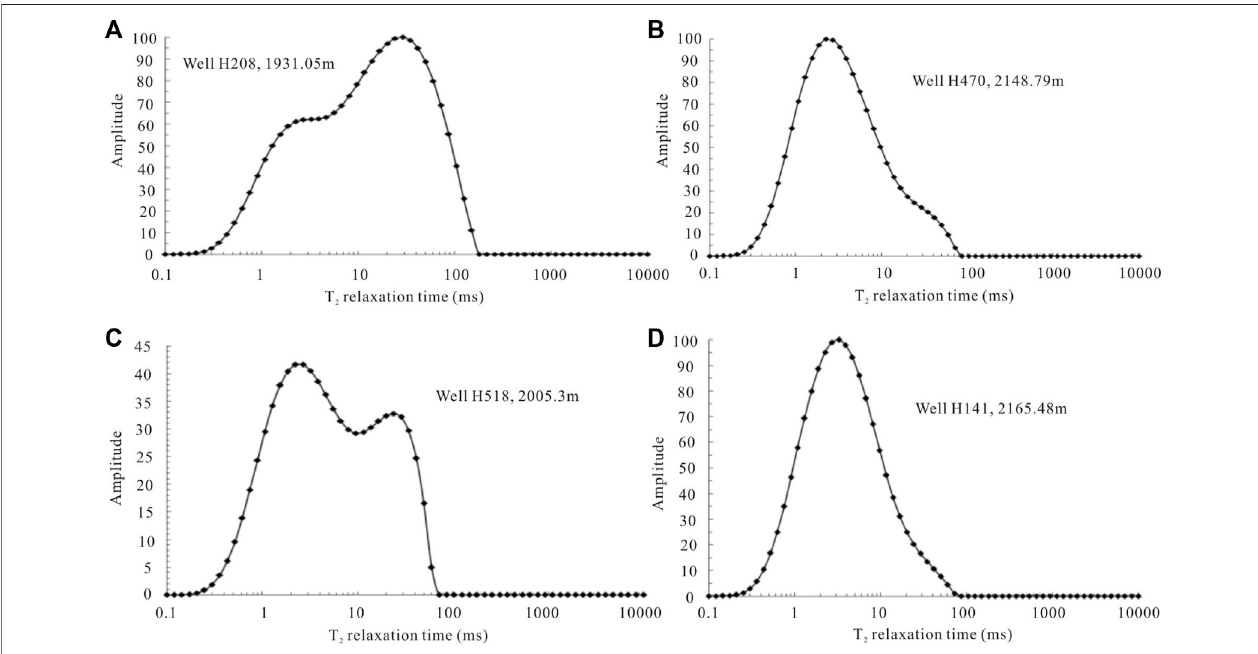
FIGURE5| DistributioncharacteristicsofdifferenttypesofT 2 relaxationtimes. (A) WellH208,1931.05 m; (B) WellH470,2148.79 m; (C) WellH518,2005.3 m; (D) Well H141, 2165.48 m.